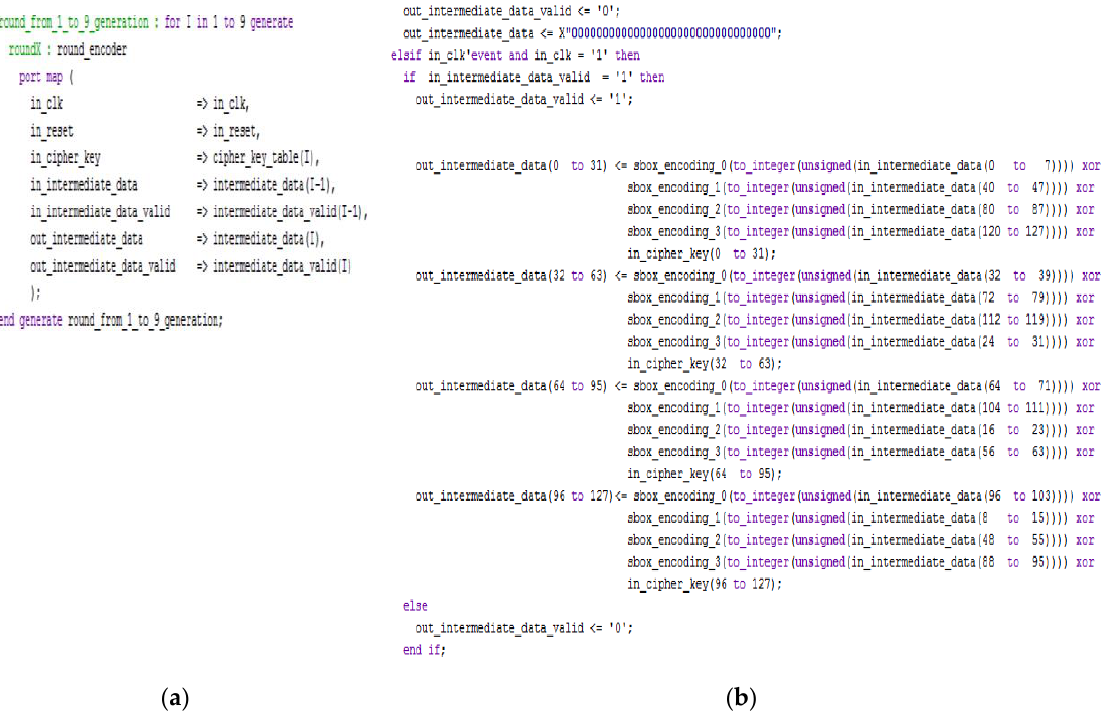
Figure 13. Generation of the 9 intermediate rounds implementing the operation provided by the AES-128 ( a ); code section implementing the operations required by each round ( b ).